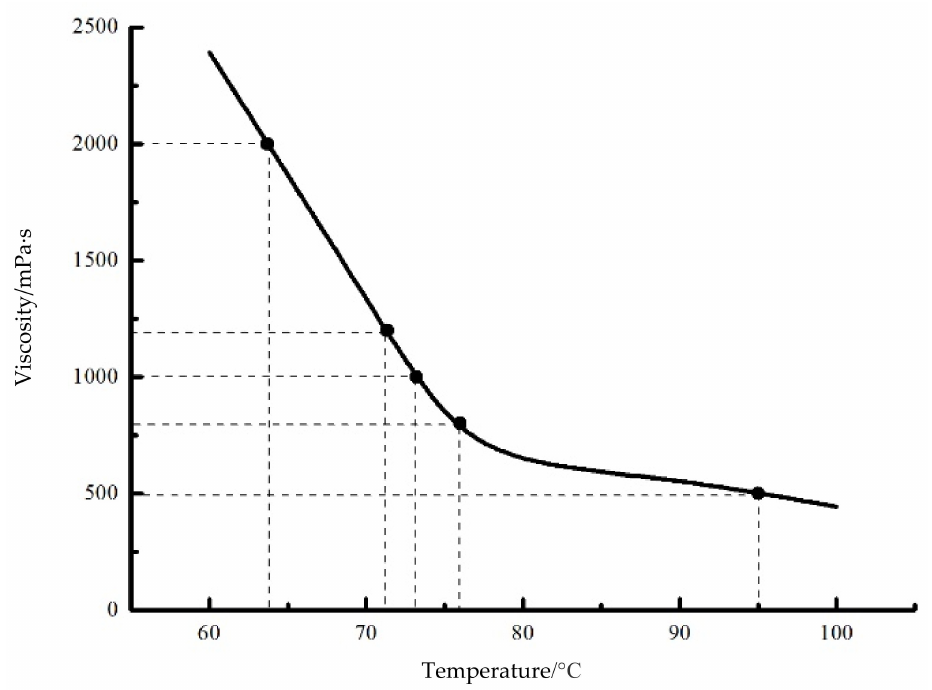
Figure 14. Viscosity and temperature characteristic curve of the epoxy